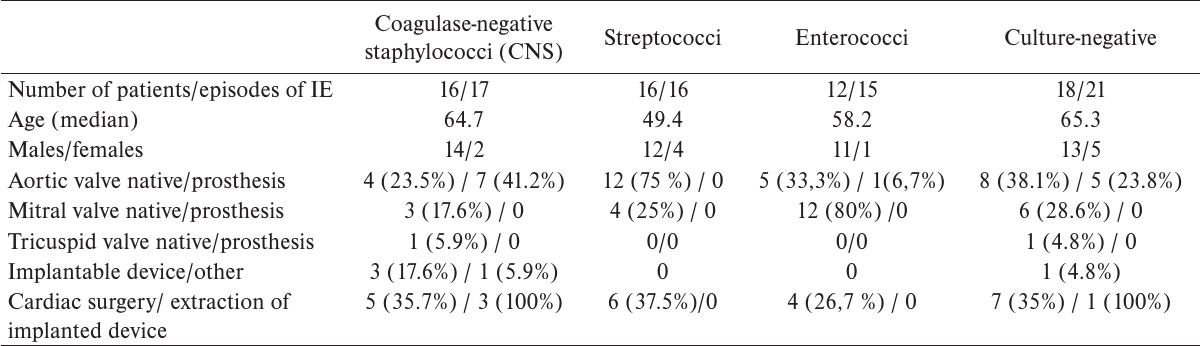
Table 5. Demographic data of the four major IE aetiological agents other than S. aureus .